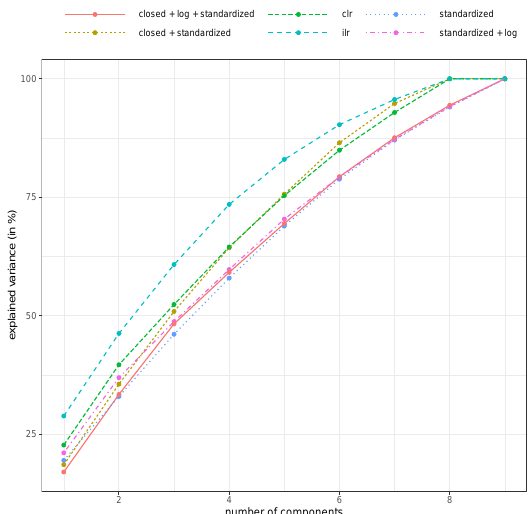
Figure 2. Explained variance (in %, cumulative) for different numbers of components and different pre-processing of the compositional honey samples. Abbreviations: clr: centered log-ratio coordinates, ilr: isometric log-ratio transformed data (i.e., pivot